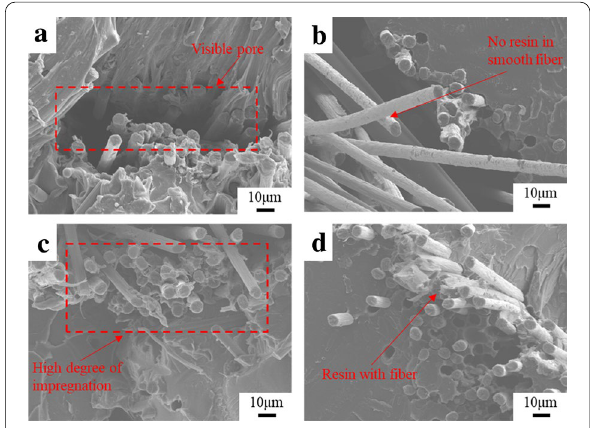
Figure 6 Fracturing-interface microstructures of the cross section at various nozzle temperatures after tensile tests: a and b 180 °C, c and d 220 °C